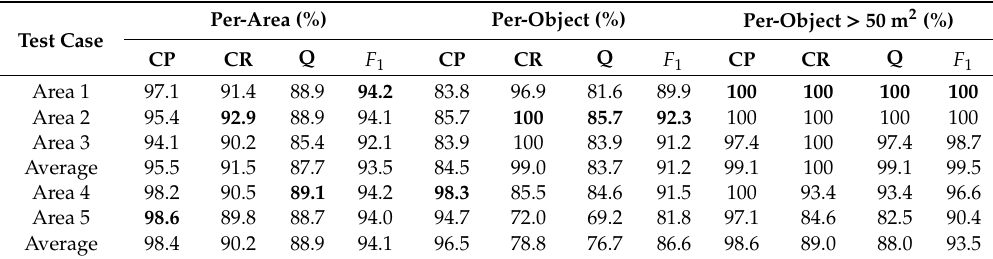
Table 1. Building extraction results. (The best values per column are shown in the bold font.).